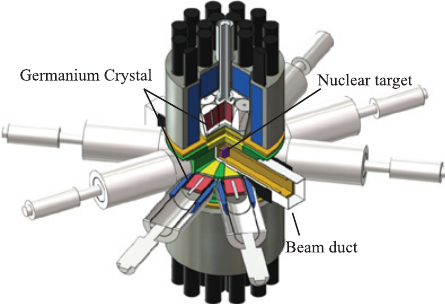
Figure 4. Schematics of the germanium spectrometer at the ANNRI beam line.